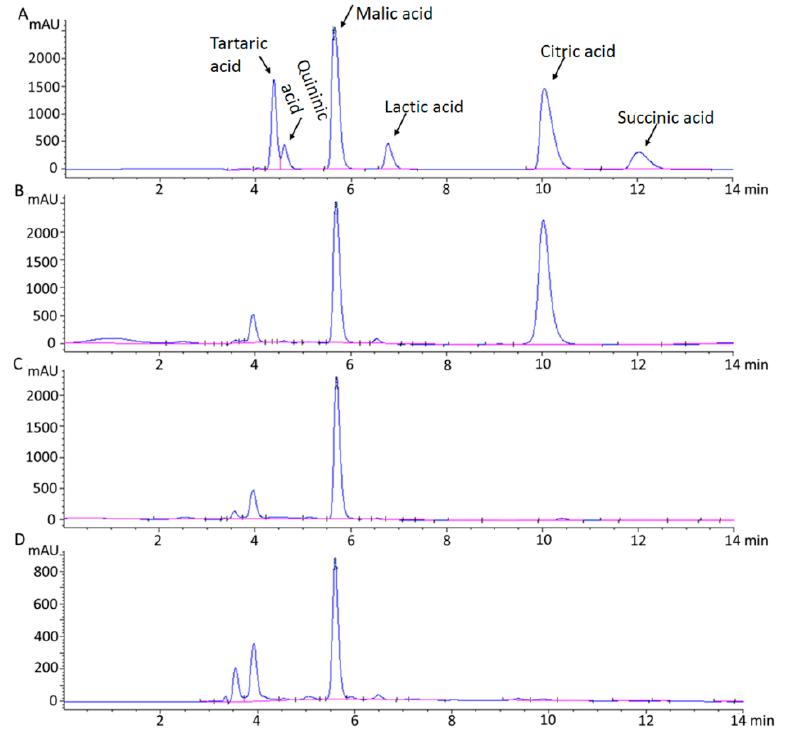
Figure 1. Chromatogram of organic acids obtained at 210 nm: ( A ) standard mixture; ( B ) Malus toringo ; ( C ) M. sieversii ; ( D ) M. sylvestris . The retention times of tartaric acid, quininic acid, malic acid, lactic acid, citric acid, and succinic acid were 4.371 min, 4.598 min, 5.643 min, 6.766 min, 10.044 min, and 12.034 min, respectively.